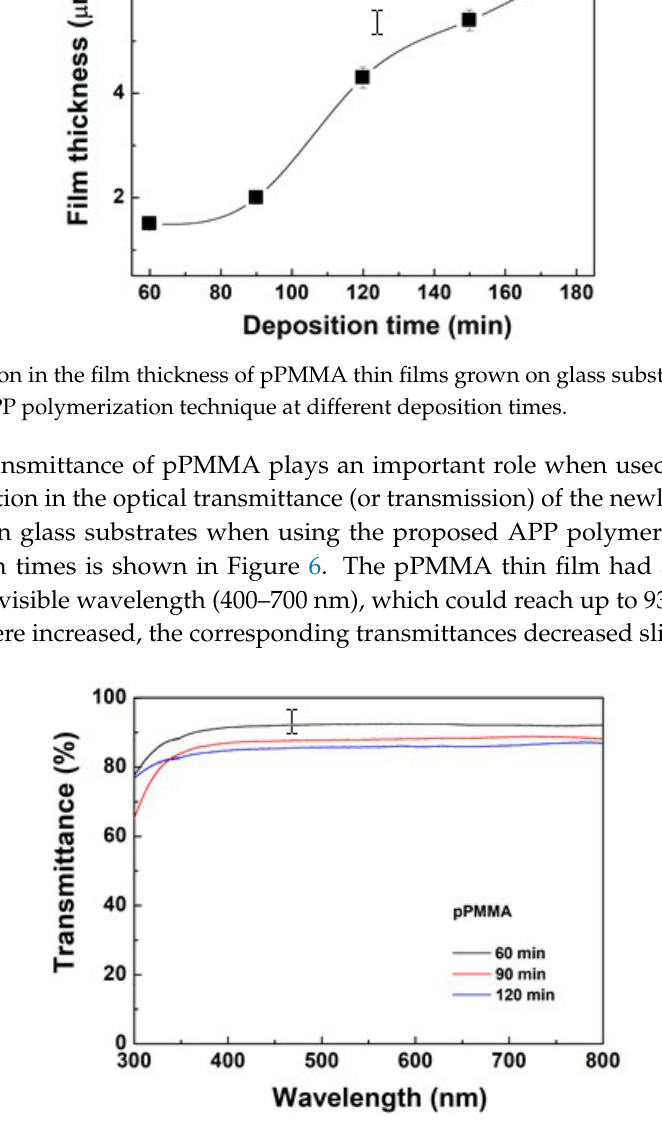
Figure 6. Variation in the optical transmittance (or transmission) of pPMMA thin films grown on glass substrates when using the proposed APP polymerization technique at different deposition